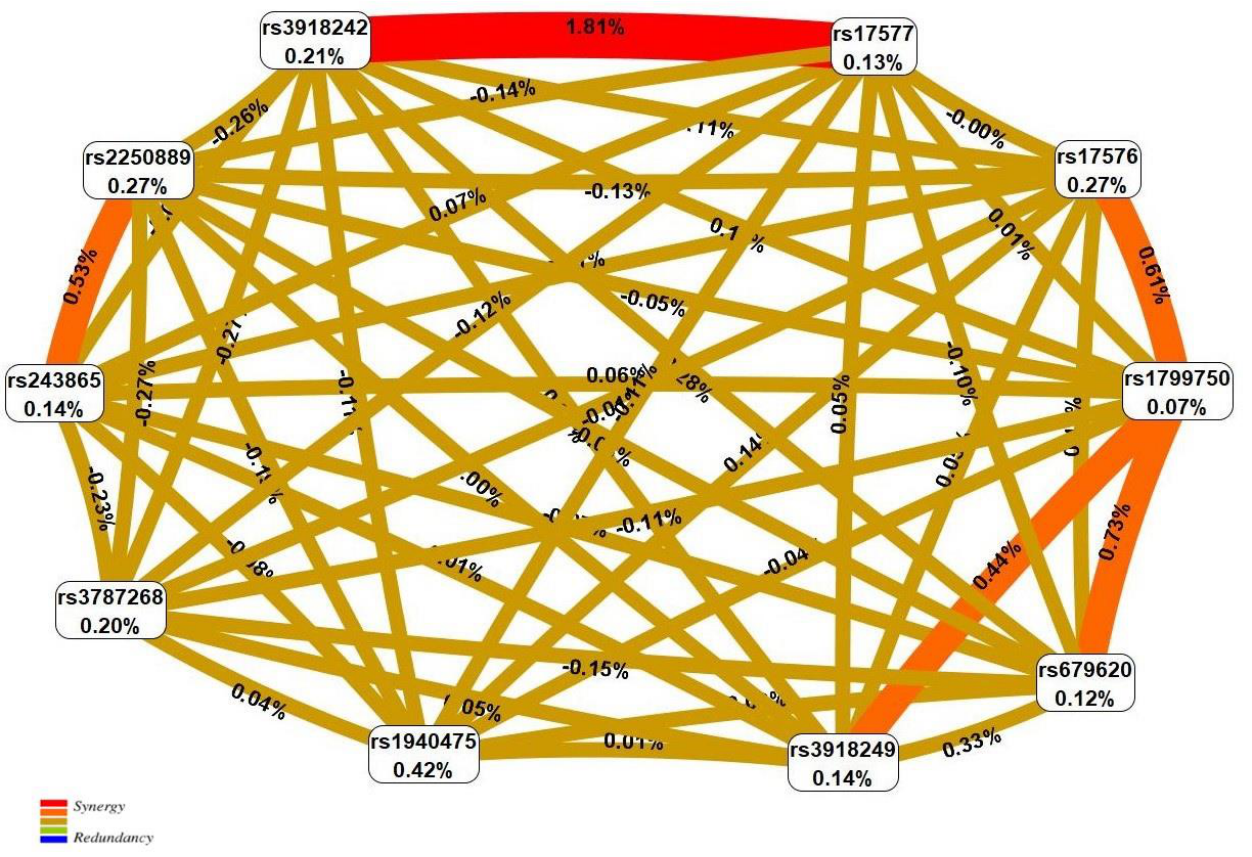
Figure 1. Entropy graph of the SNP × SNP interactions with breast cancer based on the MDR analysis. Positive entropy values indicate synergistic interactions while negative values indicate redundancy. The red and orange colors denote strong and moderate synergism, respectively; the brown color denotes an independent effect.